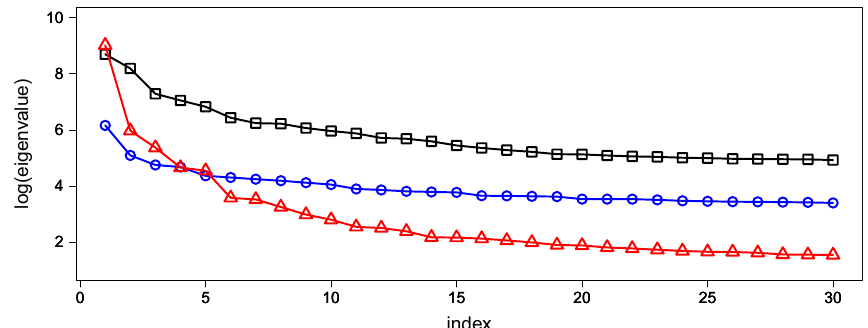
Figure 2. Logarithm graph of the largest 30 eigenvalues of (cid:31) 1 (square), (cid:31) 2 (circle) and (cid:31) 3 (triangle). The horizontal axis expresses the index of eigenvalues arranged in descending